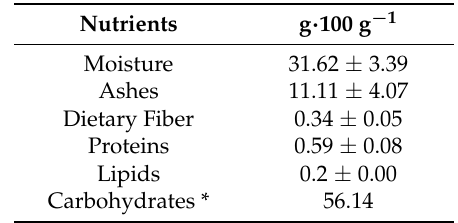
Table 3. Chemical composition (mean ± SD) of dehydrated beet stalks and leaves ( Beta vulgaris L.), expressed as g · 100 g − 1 stalks and leaves (dry